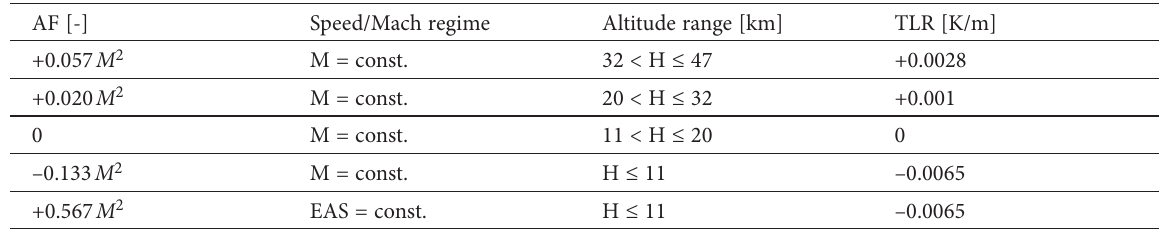
Table 1. Acceleration factors for ISA troposphere and stratosphere AF [-] Speed/Mach regime Altitude range [km] TLR [K/m] +0.057 M